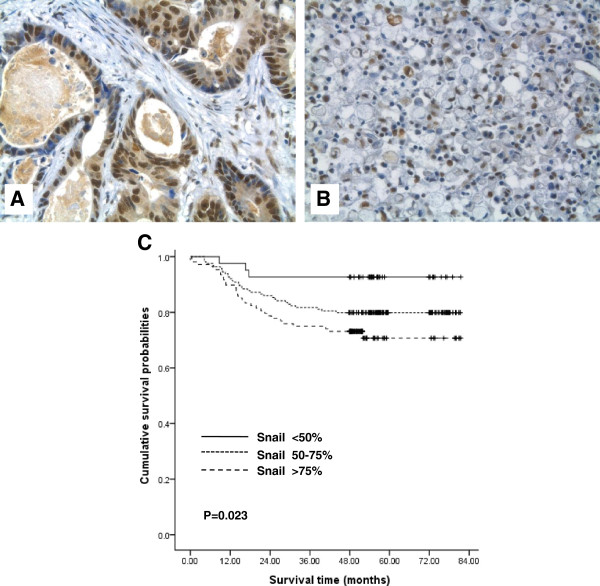
Snail expression in gastric adenocarcinoma (GC) tissue samples and Kaplan–Meir plots of overall survival of 314 GC patients. Snail was mostly expressed in nuclei of GC cells (intestinal type (A), and diffuse type (signet ring) cells (B)) included in tissue array specimens. Some reactive fibroblasts also showed Snail nuclear expression (magnification: ×400). C. Kaplan–Meier analysis of overall survival of GC patients based on Snail expression. A linear relationship between increased Snail nuclear expression and shorter survival was seen among GC patients (P = 0.023). Log-rank test was used to calculate P values.